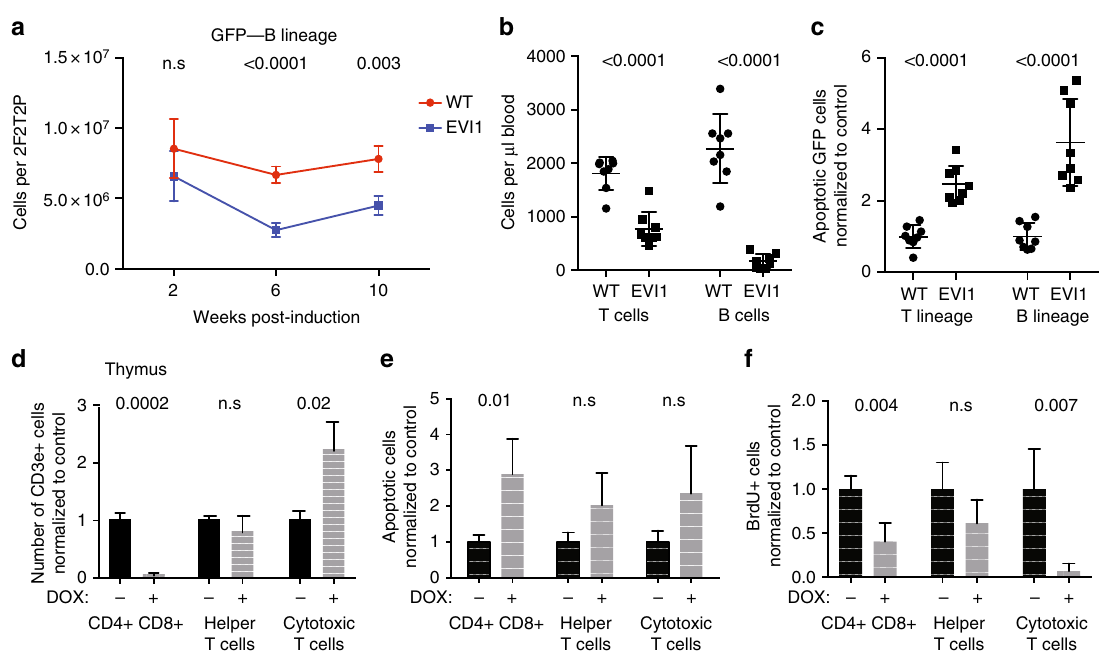
Fig. 3 EVI1 overexpression suppresses lymphopoiesis. a Quanti fi cation of B lymphocytes (B220 + ) cells overexpressing EVI1 (GFP − ) and WT control (GFP − ) in WBM of competitively transplanted recipients harvested 2, 6, or 10 after DOX induction. (WT n = 4 mice, EVI1 n = 4 mice at each time point, total n = 24). b Circulating donor-derived T cells (GFP − , CD3e + , CD11b − ) and B cells (GFP − , CD19 + , CD11b − ) in competitively transplanted mice at 10 weeks post induction. Each time point (WT n = 8 mice, EVI1 n = 8 mice). c Quanti fi cation of apoptotic (annexin-V + , 7AAD − ) T lymphocytes (CD3e + ) and B lymphocytes (B220 + ) overexpressing EVI1 (GFP − ) compared to WT (GFP − ) in WBM of competitively transplanted recipients harvested 10 weeks after DOX induction. Each dot represents an individual recipient mouse. (WT n = 8 mice, EVI1 n = 8 mice). d Quanti fi cation of CD4/CD8 double-positive cells (CD3e + , CD4 + , CD8a + ), helper T cells (CD3e + , CD4 + , CD8a − ), and cytotoxic T cells (CD3e + , CD4-, CD8a + ) in thymus of Evi1 TO/TO Rosa26 rtTA/rtTA mice harvested 48 h with or without DOX induction. (WT n = 4, EVI1 n = 4). e Quanti fi cation of apoptotic (annexin-v + 7AAD − ) CD4/ CD8 double-positive cells (CD3e + , CD4 + , CD8a + ), helper T cells (CD3e + , CD4 + , CD8a − ), and cytotoxic T cells (CD3e + , CD4 − , CD8a + ) in thymi of Evi1 TO/TO Rosa26 rtTA/rtTA mice harvested 48 h with or without DOX induction. (WT n = 4, EVI1 n = 4). f Quanti fi cation of BrdU + CD4/CD8 double-positive cells (CD3e + , CD4 + , CD8a + ), helper T cells (CD3e + , CD4 + , CD8a − ), and cytotoxic T cells (CD3e + , CD4 − , CD8a + ) in thymi of Evi1 TO/TO Rosa26